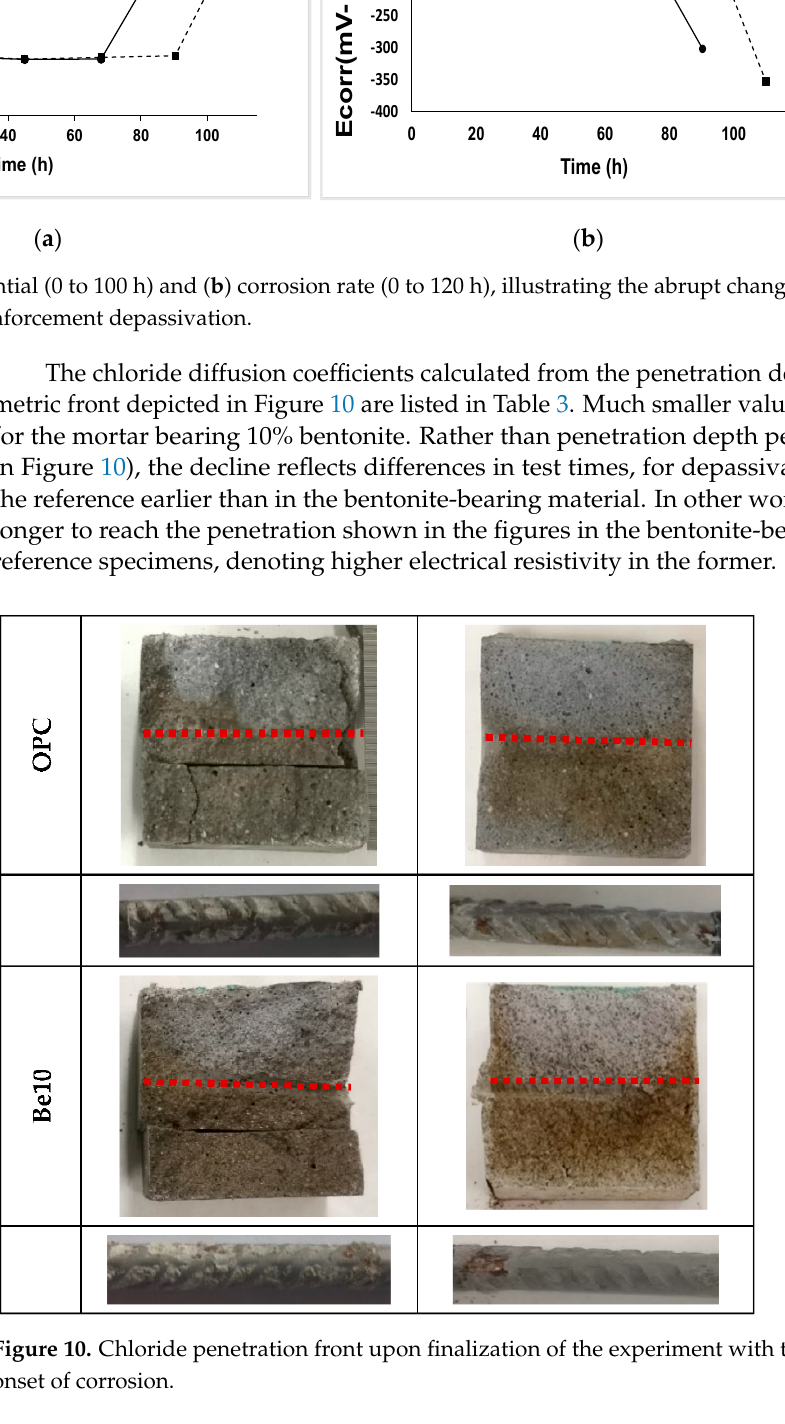
Figure 10. Chloride penetration front upon finalization of the experiment with the detection of the onset of corrosion.